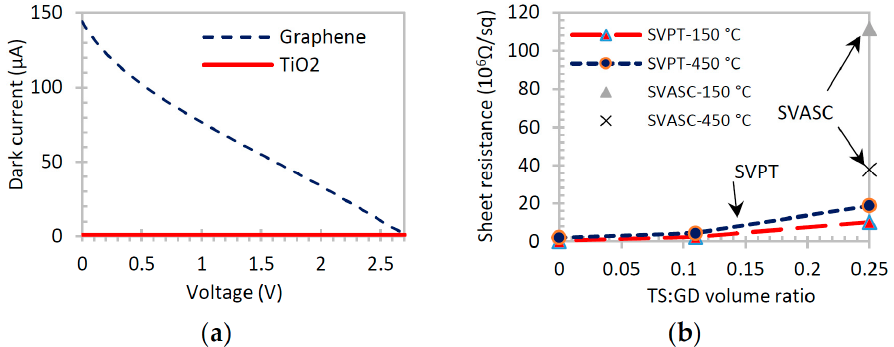
Figure 7. ( a ) Typical dark I ‐ V curves of graphene and TiO 2 films; ( b ) influence of TiO 2 content and annealing temperature on the sheet resistance of graphene ‐ TiO 2 thin films.